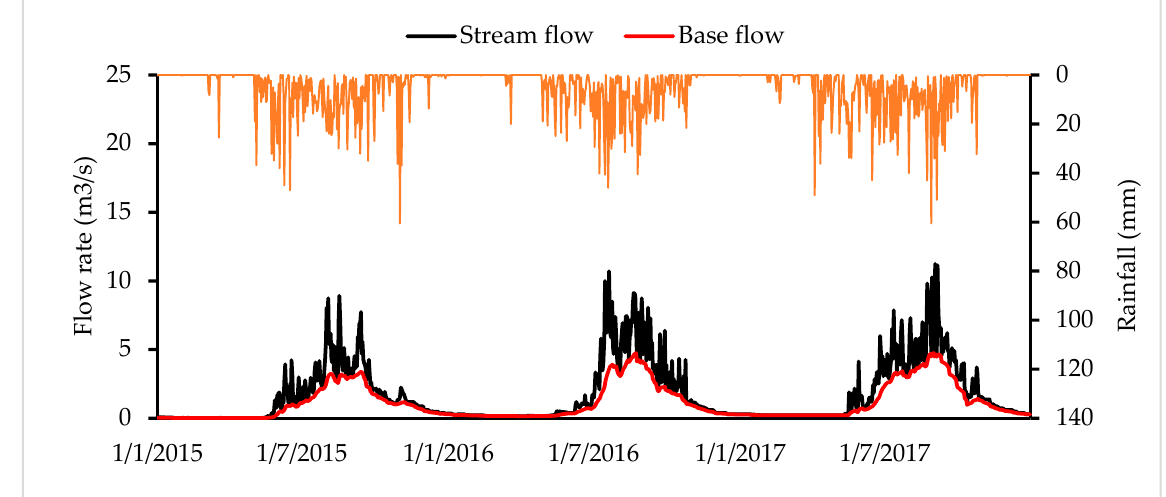
Figure 7. Stage–discharge relationship (rating curve) for Brantie River.